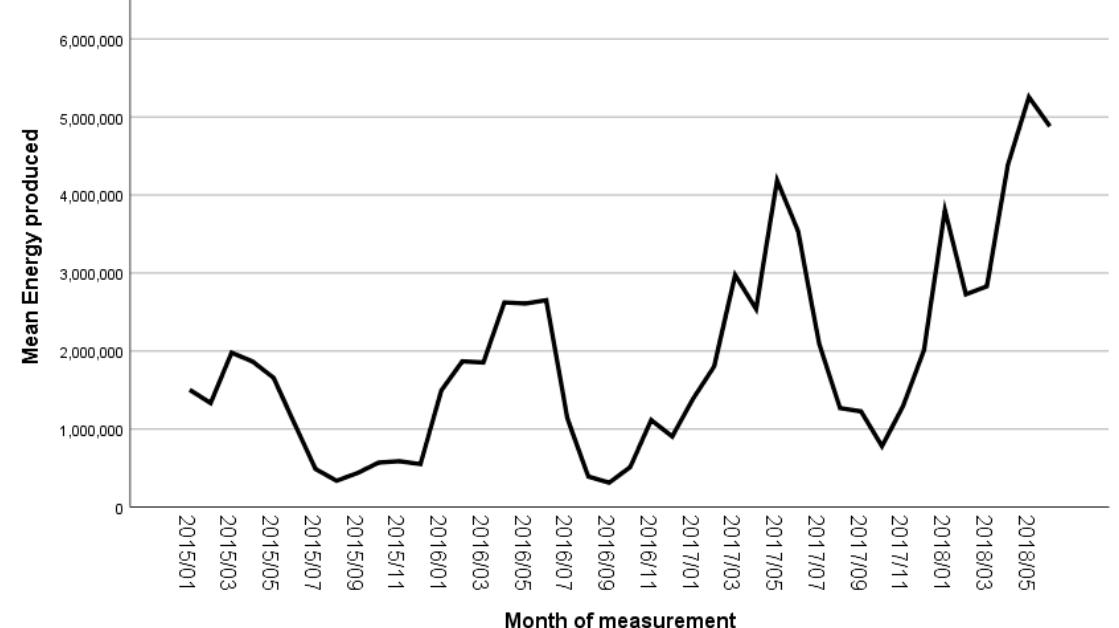
Figure 6. Mean monthly energy produced for the period examined.